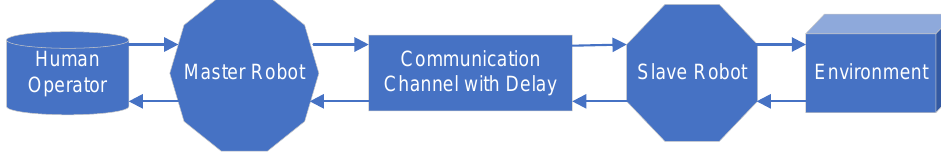
Figure 1. The control structure of the bilateral teleoperation robot system.